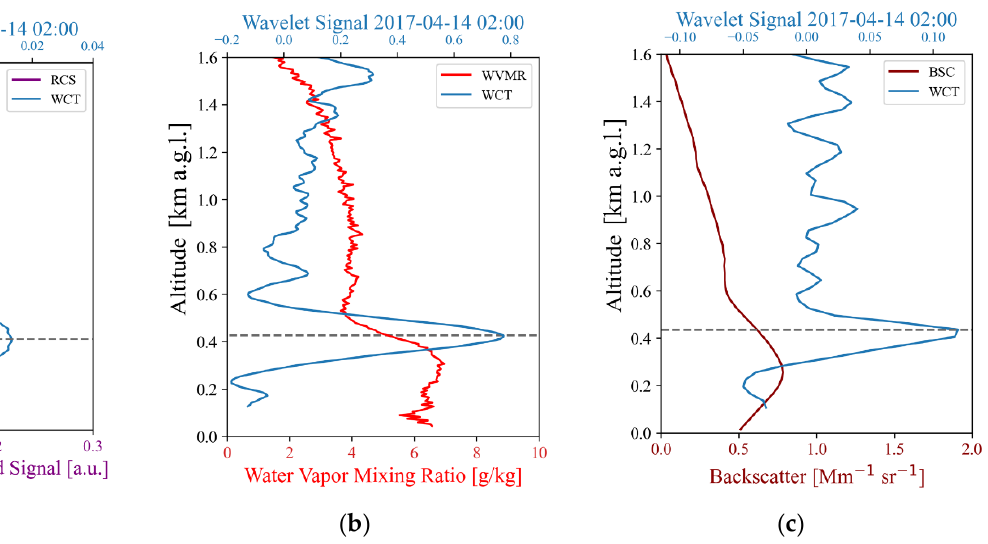
Figure 2. Wavelet Signal (Blue lines) from 14 April 2017 02:00 UTC, for ( a ) 532 nm Near Field channel Range Corrected Signal (purple line) from PollyXT Lidar, ( b ) Water Vapor Mixing Ratio (red line) from PollyXT Lidar and ( c ) Attenuated Backscatter Coefficient (brown line) from Halo Lidar.